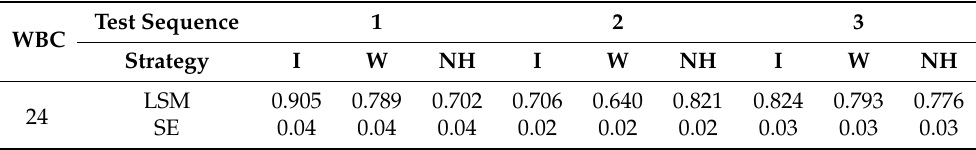
Table 14. Results for WBC [10 3 /mm 3 ] measured 24 h after the test performed using different hydration strategies (I, W, BN) in three consecutive tests (1, 2, 3): marginal means (LSM) and standard errors (SE) for values after logarithmic transformation (log).